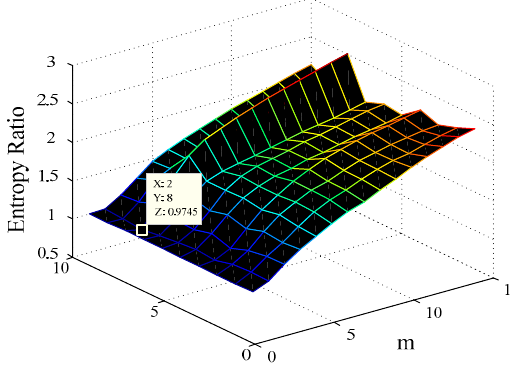
Figure 9. IGBT experimental data (IGBT3) entropy ratio diagram.